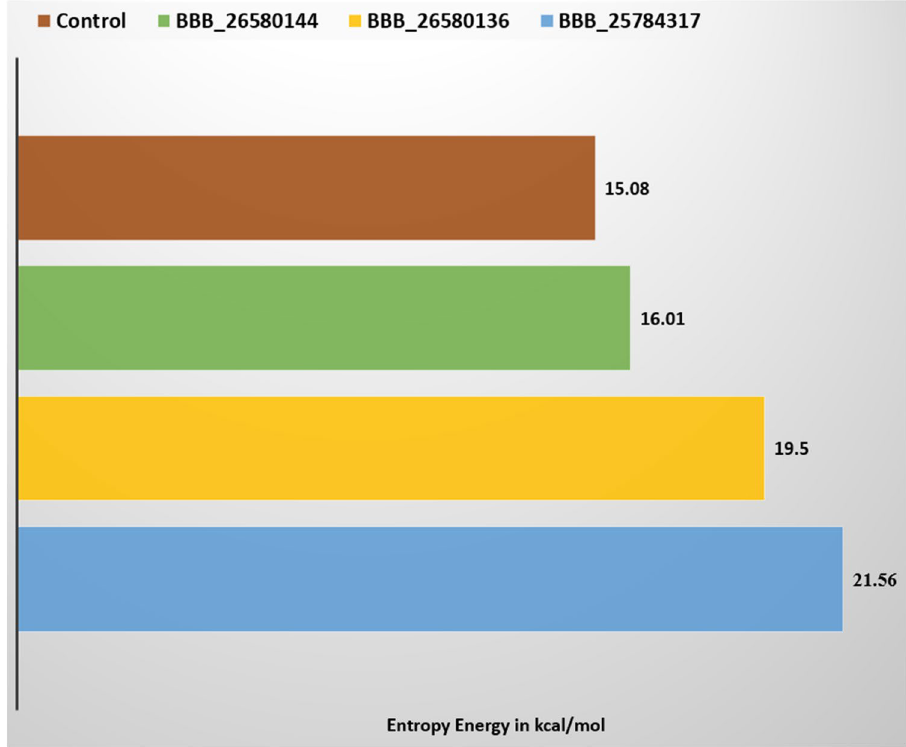
Figure 8. Entropy energy analysis of docked systems. All values are in kcal/mol.